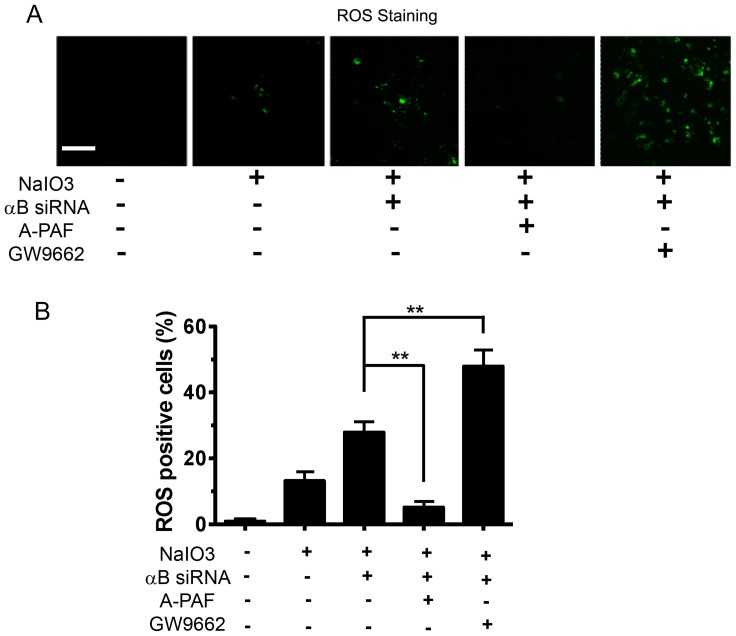
Detection of reactive oxygen species (ROS) in the presence and absence of PPARγ ligand/antagonist.Increased production of ROS was observed in RPE cells transfected with αB crystallin siRNA upon NaIO3 treatment as compared to control group. A-PAF, a PPARγ ligand, suppressed ROS production significantly (P<0.01) in αB crystallin siRNA transfected cells treated with NaIO3 (A). On the other hand, GW9662, a PPARγ antagonist significantly increased ROS positive cells in αB crystallin siRNA transfected cells treated with NaIO3. ROS positive cells were quantified from four random images derived from 4 individual experiments. αB siRNA refers to αB Crystallin siRNA. (B). Scale bar = 40 µm. **P<0.01.